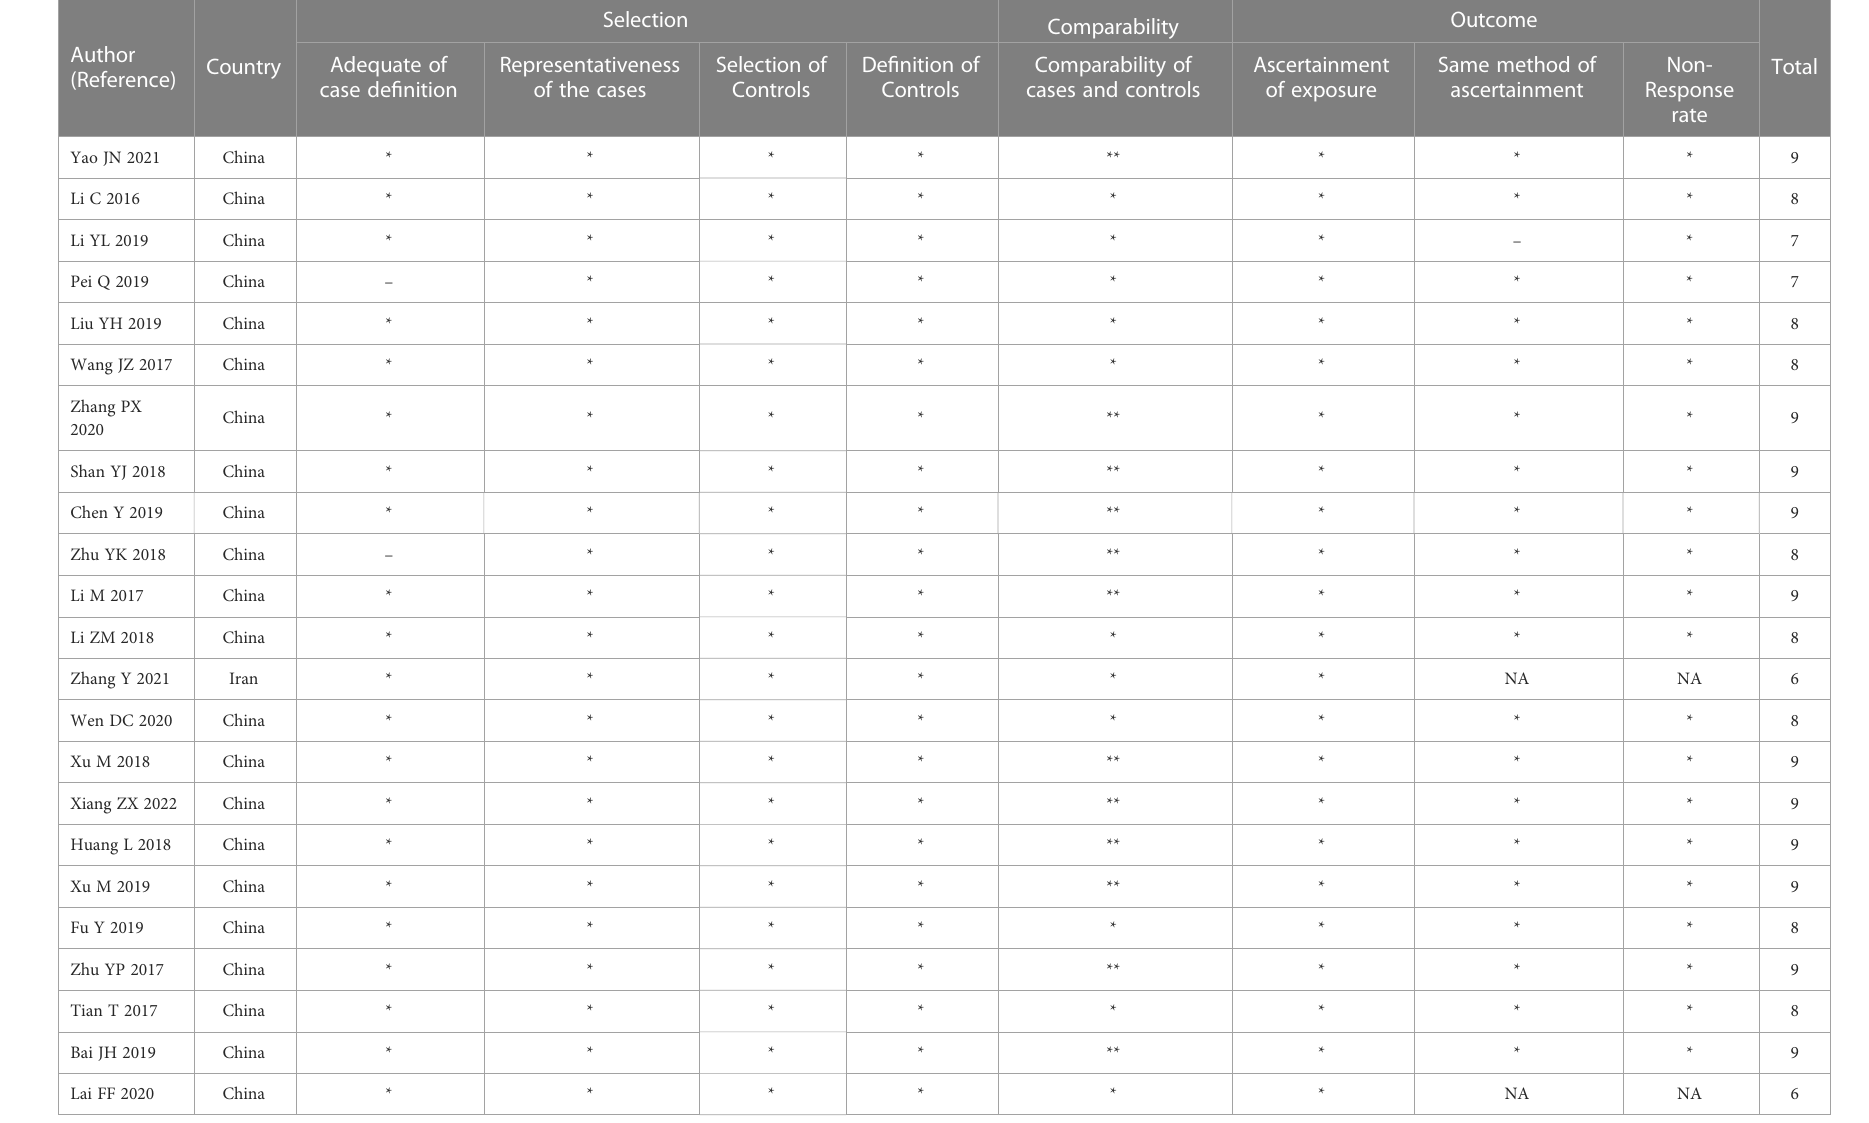
TABLE 2 Quality assessment of eligible studies (Newcastle-Ottawa scale) (NOS